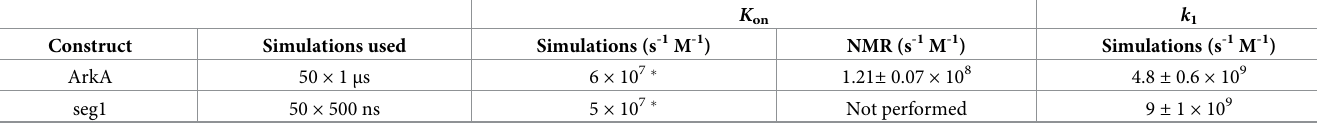
Table 5. Binding rate constants for ArkA and seg1 determined from binding simulations and NMR